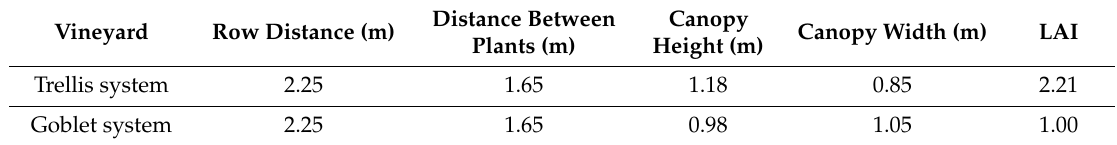
Table 2. Canopy characterization parameters for the two training systems where the trials took place at BBCH